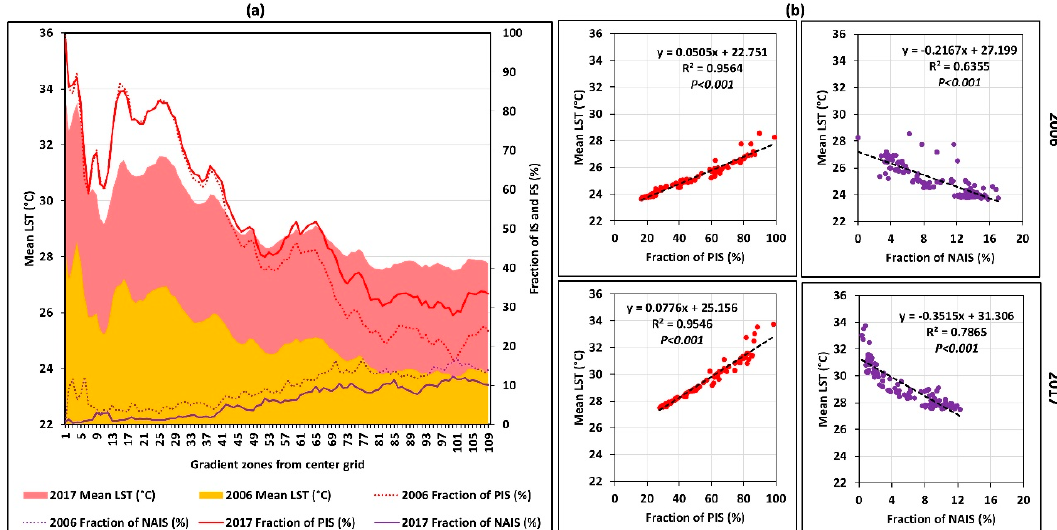
Figure 4. ( a ) Spatial distribution of mean LST and fraction of PIS and NAIS through the GZs; and ( b ) scatter plots among mean LST and fraction of PIS and NAIS in 2006, and 2017.